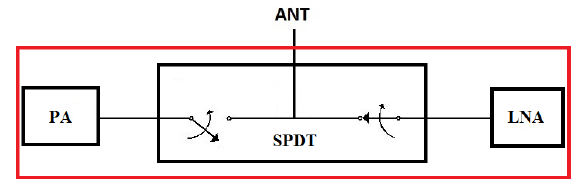
Figure 26: GaN transceiver